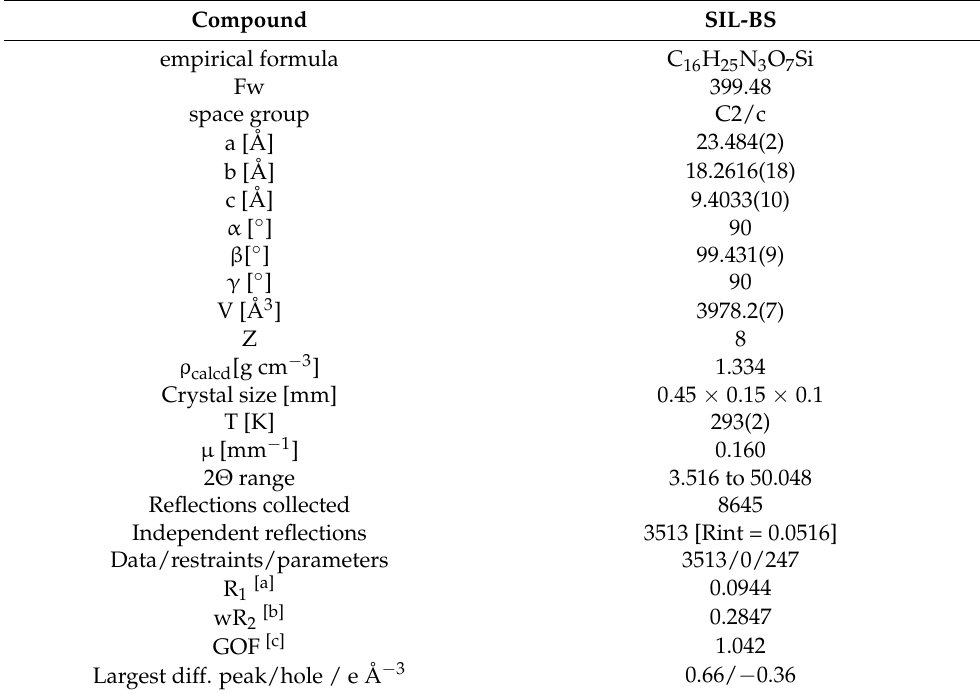
Table 3. Crystal data and details of data collection for SIL-BS.